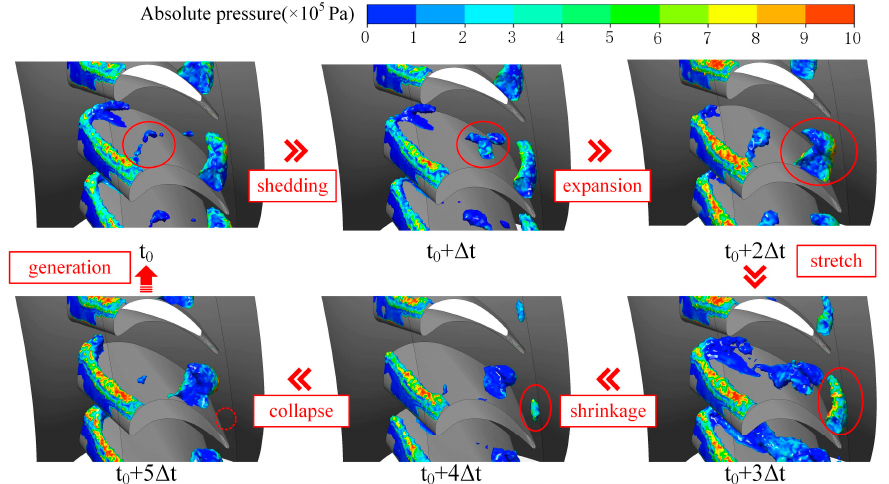
Figure 21. Transient cavitation evolution in the stator.